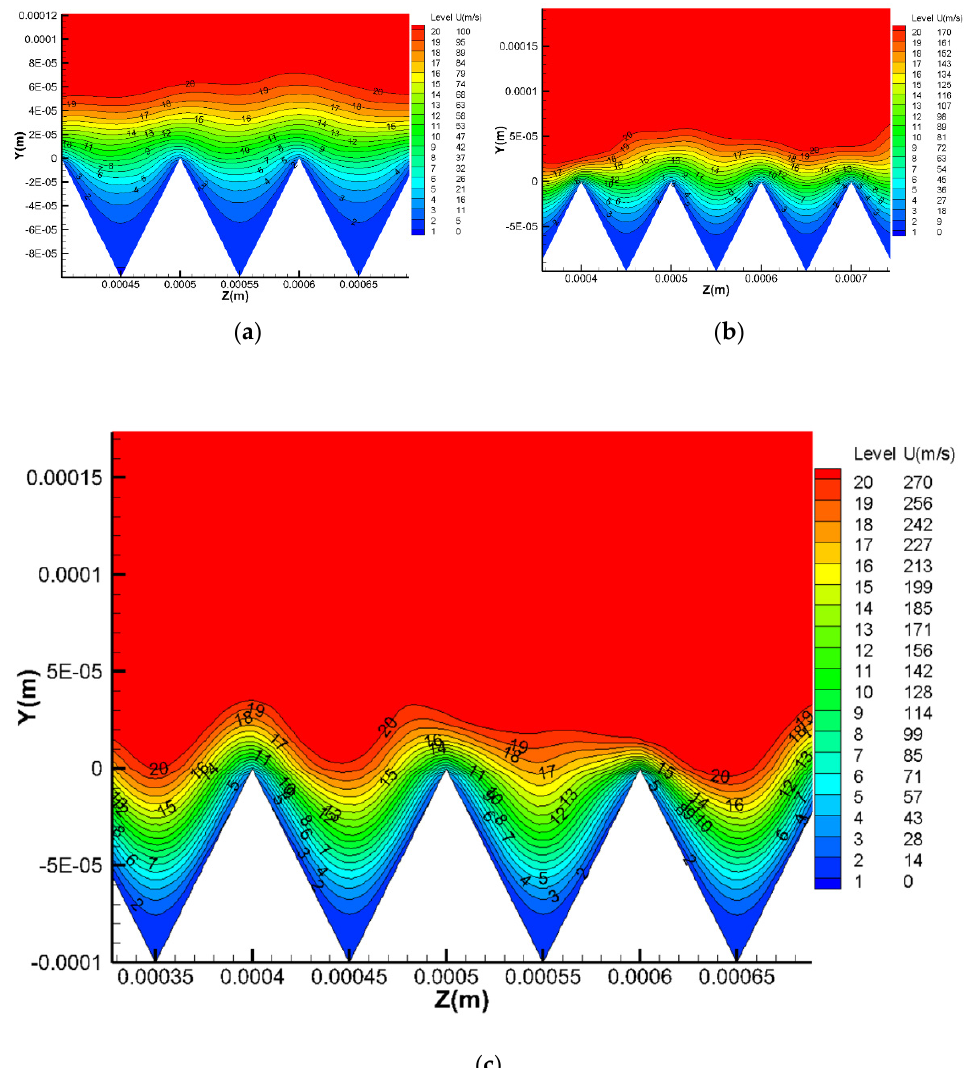
Figure 16. Flow plane velocity cloud picture of triangular groove plate under different Mach number; ( a ) 0.3 Ma; ( b ) 0.5 Ma; ( c ) 0.8 Ma. (2) Reynolds